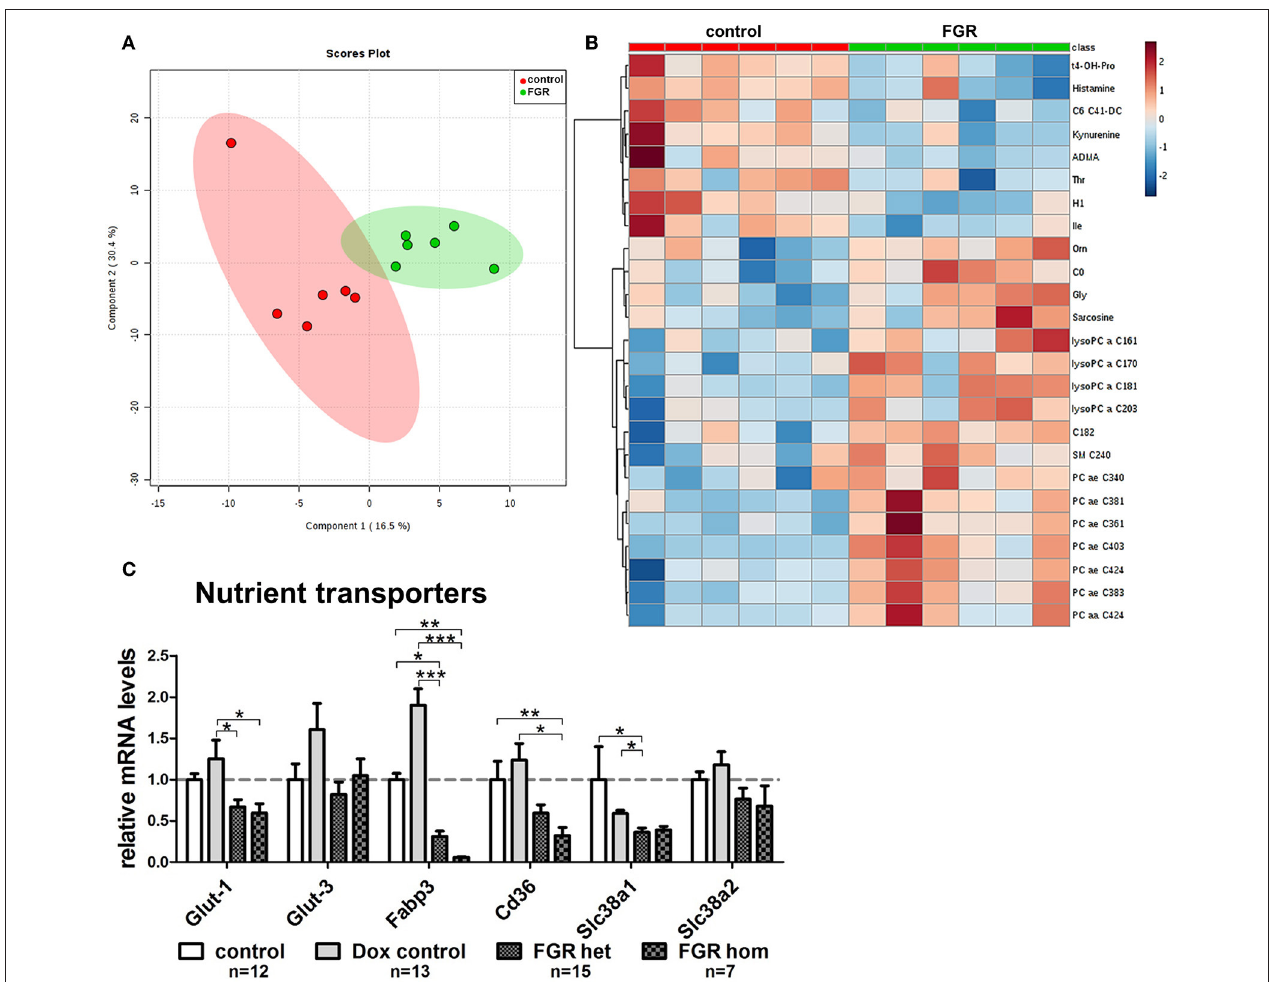
FIGURE 8 | Maternal metabolome analysis and placental expression of nutrient transporter genes in the hsFLT1/rtTA mouse model. (A) Supervised partial least squares discriminant analysis (PLS-DA) of 152 metabolites detected the main metabolomic differences in serum from fetal growth restriction dams (FGR; n = 6; green dots) and control dams ( n = 6; red dots). (B) Heat map representation of the top 25 modified metabolites in each group ( n = 6 each) mainly indicated accumulation of lysophosphatidylcholines and phosphatidylcholines in serum from hsFLT1–expressing dams (color-coding intensity in the red spectrum shows an increase in the number of given metabolites, and color intensity in the blue spectrum shows a decrease in the number of the given metabolites). (C) Results of quantitative reverse transcription polymerase chain reaction (qRT-PCR) analysis of nutrient transporters in placentas from each group: FGR homozygous (hom; n = 7), FGR heterozygous (het; n = 15), control ( n = 12), and doxycycline (Dox) control ( n = 13). The mRNA expression levels of glucose transporters Glut-1 and Glut-3 , fatty acid transporters fatty acid binding protein 3 ( Fabp3 ) and Cd36 , and amino acid transporters solute carrier family members one and two ( Slc38a1 and Slc38a2 ) are lower